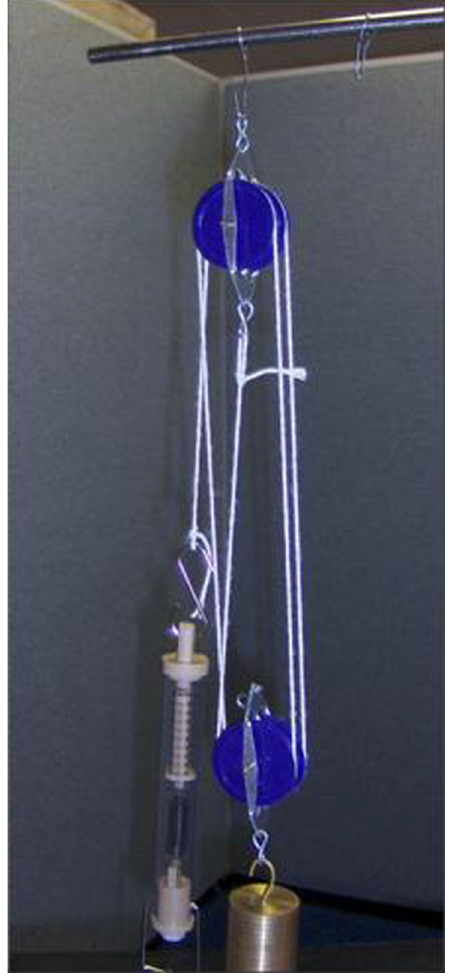
FIG. 2 (color online). The physical manipulatives for the pul- ley experiment included pulleys, string, a spring scale, a meter stick, and a